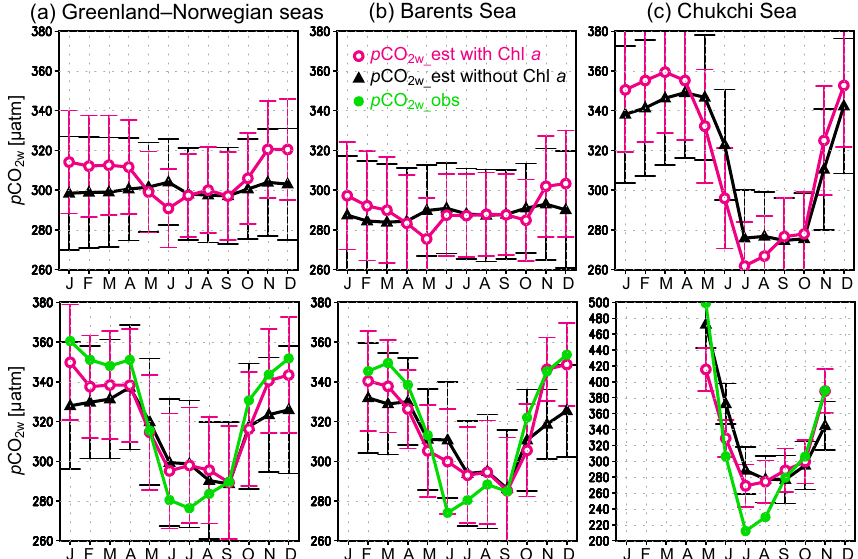
Figure 13. The 18-year averaged p CO 2w seasonal variations (µatm) in (a) the Greenland and Norwegian seas, (b) the Barents Sea, and (c) the Chukchi Sea. Black lines with triangles show estimates without Chl a ; magenta lines with open circles show estimates with Chl a ; green lines with closed circles show observed values. The upper panels show p CO 2w averaged for all grid cells within each region, and the lower panels show p CO 2w averaged over the grid boxes in which observed p CO 2w values were available. Error bars show the uncertainty, estimated as described in the